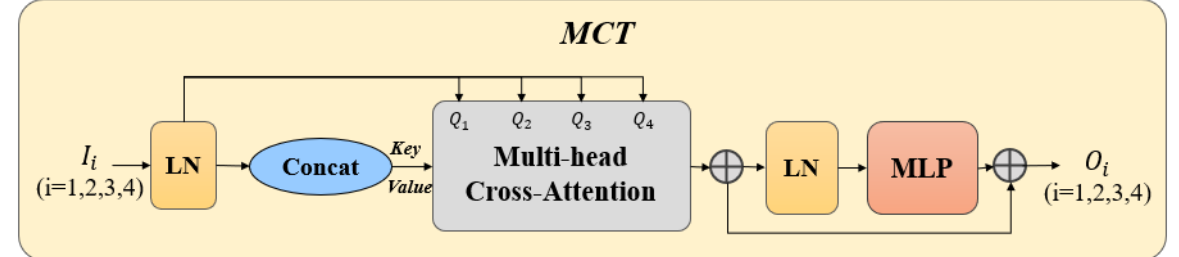
The channelized edge cross-fusion transformer consists of MCT for encoder feature transformation, MCT for encoder feature conversion, and the edge-enhancement cross- attention module (ECA) for decoder feature fusion.